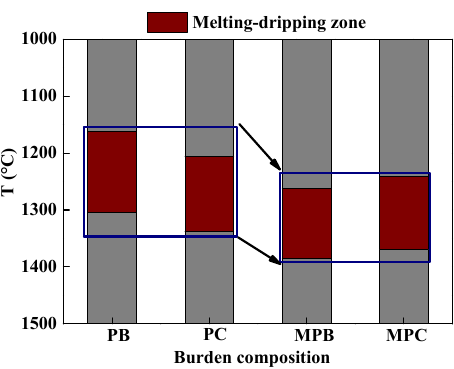
ff ect of burden composition of pellets on the location of the cohesive Figure 11. Effect of burden composition of pellets on the location of the cohesive zone. Figure 11. E